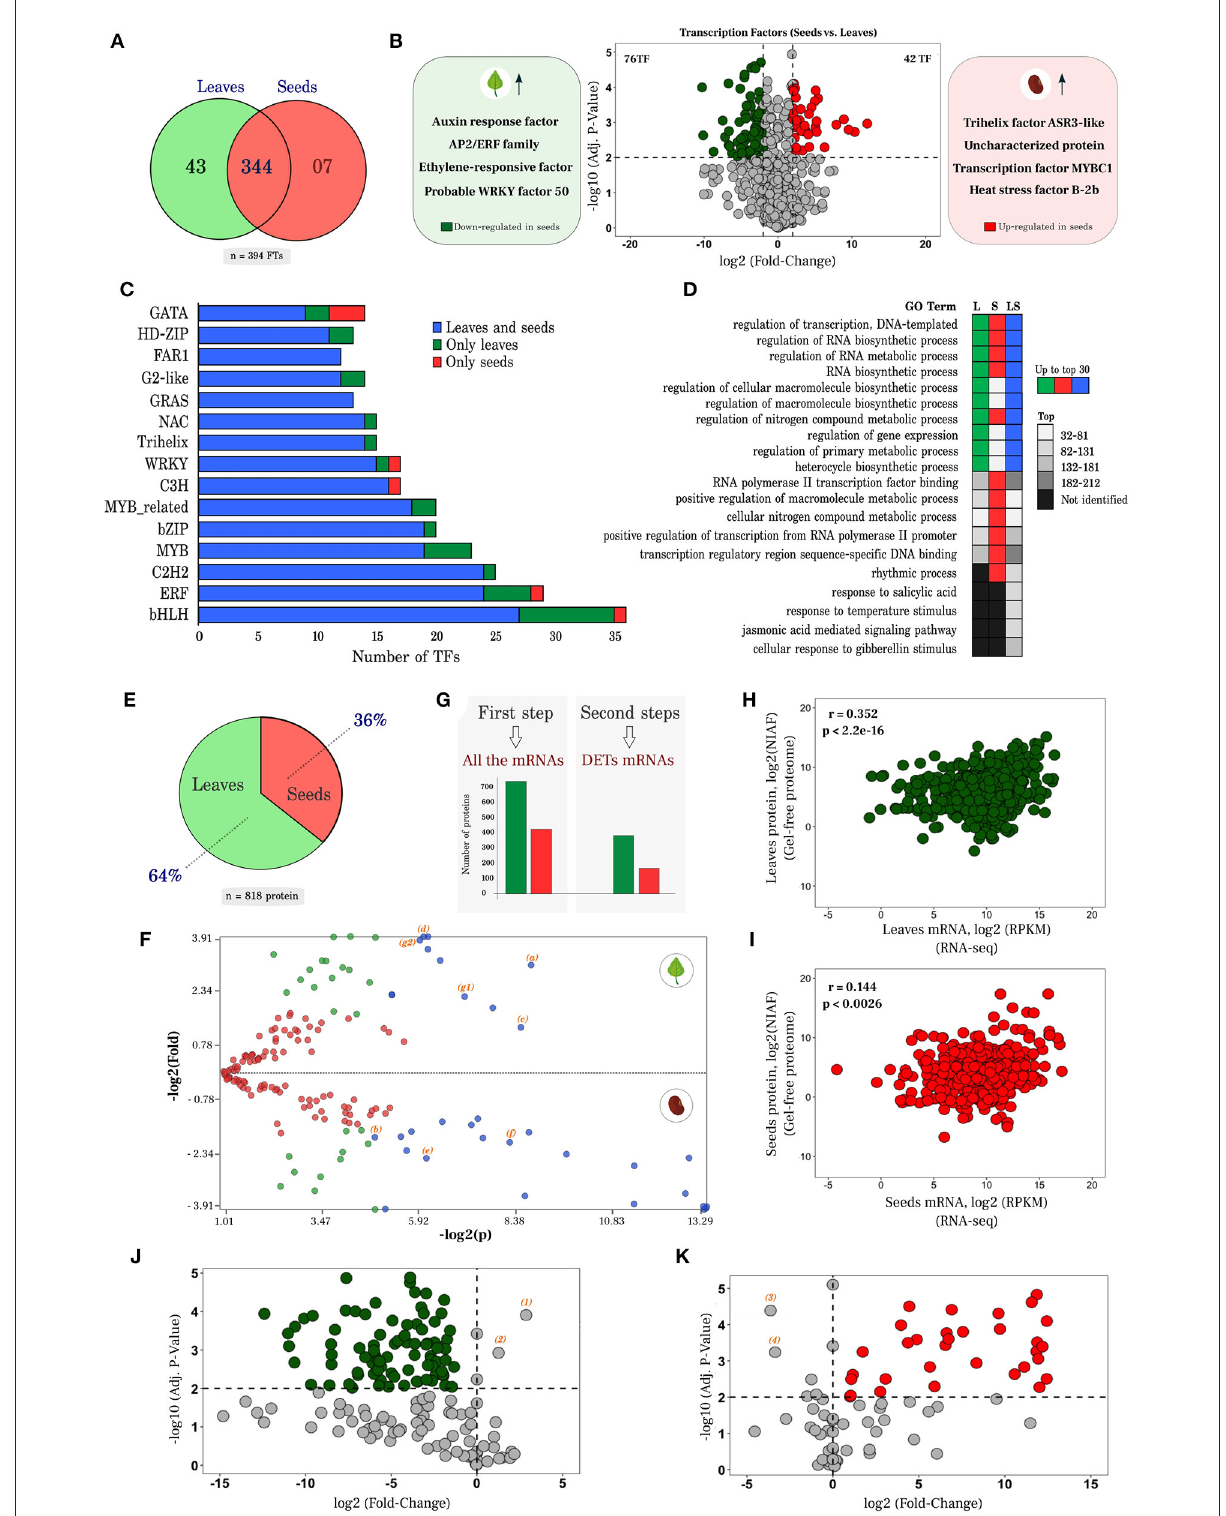
FIGURE4 Analysis of transcription factors (TFs), proteome, and correlation of mRNA vs. proteins. (A) Transcription factors identified in leaves and seeds, in a unique and common way through the PlantRegMap platform; (B) Volcano plot of the up- and down- regulated TFs. The Y axis represents